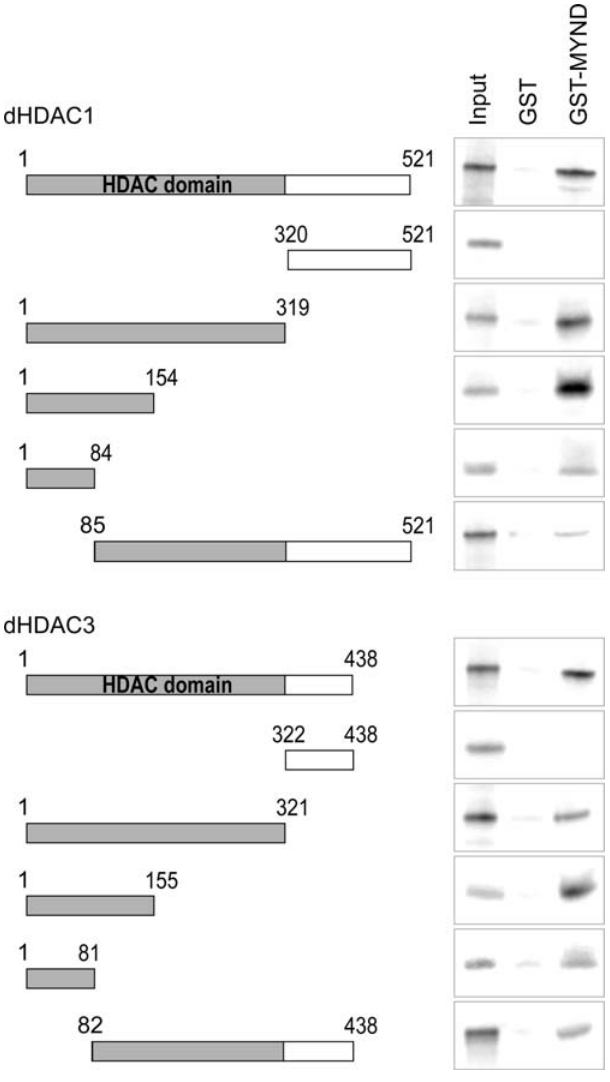
Figure 3. Mapping the interaction between dSmyd4 and dHDAC1 and dHDAC3. A GST fusion of amino acids 208–377 of dSmyd4 (GST-MYND) or GST alone were used in a pulldown assay with in vitro translated radiolabelled fragments of dHDAC1 or dHDAC3. The schematics on the left indicate the fragments used.